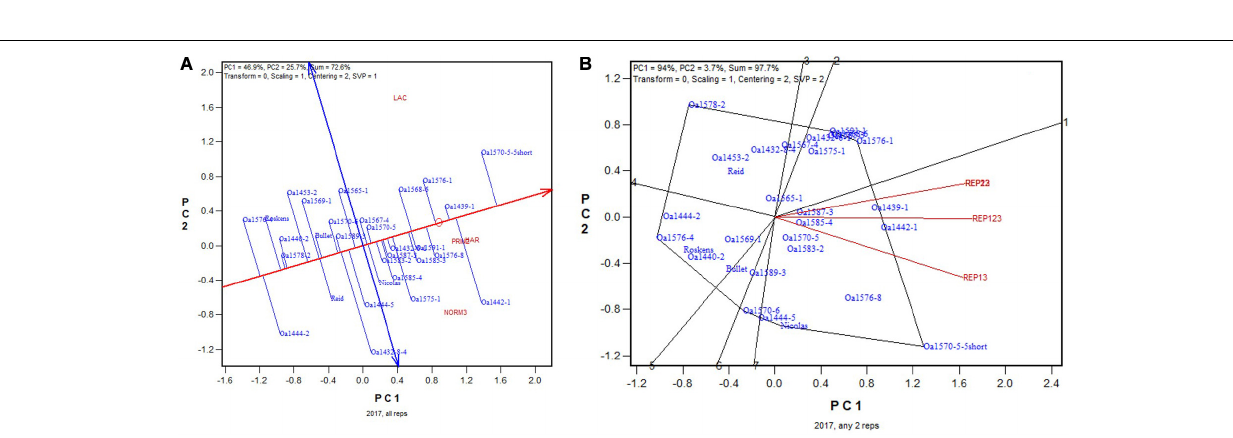
FIGURE 10 | Biplots for the 2017 non-Ontario trials. (A ) GGE biplot to show genotype ranking based on data from all three replicates, and (B) summary biplot to show the genotype rankings based on all three replicates and on any two of them. REP123, genotypic ranking based on all three replicates; REP12, genotype ranking based on replicates 1 and 2; REP13, genotype ranking based on replicates 1 and